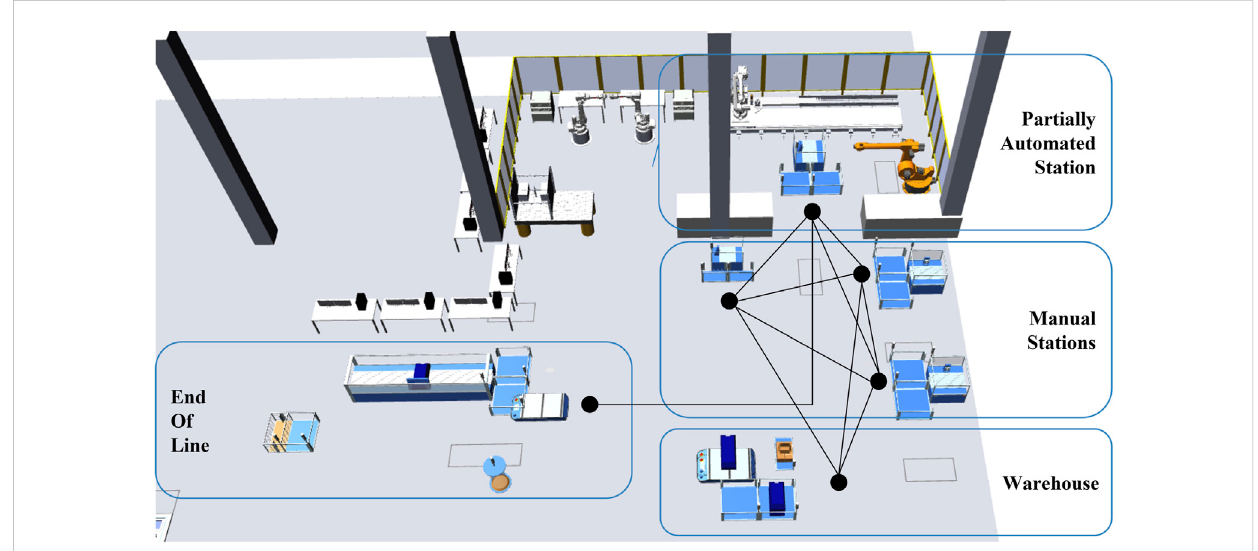
FIGURE 12 Discrete-event simulation model of the line-less assembly demonstrator (cf. Mathews et al., 2022).